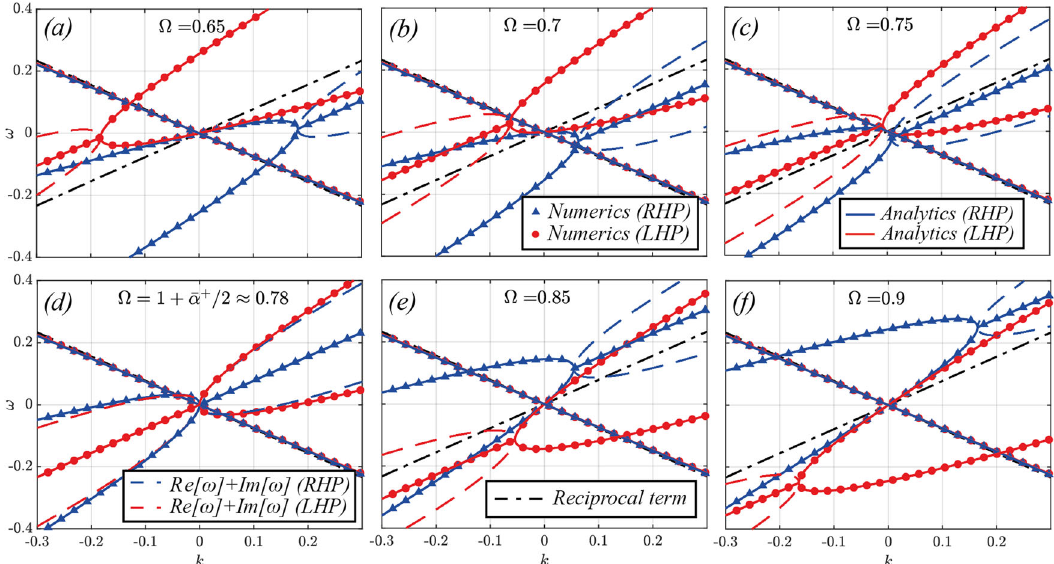
Fig. 3 Band structure of the photonic Archimedes ’ Screw near the origin for the zero-dephasing (impedance-matched) case across the luminal v s → 1 regime. Continuous lines denote analytic solutions for the lowest LHP (red) and RHP (blue) bands, and dots (LHP) and triangles (RHP) of the respective colours correspond to numerical simulations. The different panels correspond to different modulation frequencies (and velocities) across the luminal ¼ 1 þ (cid:2) α þ = 2 (cid:4) 0 : 78, ( e ) Ω = 0.85 and ( f ) Ω = 0.9. Note how the exceptional points for the regime ( a ) Ω = 0.65, ( b ) Ω = 0.7, ( c ) Ω = 0.75, ( d ) Ω ¼ Ω 0 crit RHP bands in the fi rst quadrant reaches the origin for Ω ¼ Ω 0 , giving rise to a broadband chiral PT-broken phase. In addition, at this critical point the crit optical drag fl ips sign from negative (opposing the fl ow of light) to